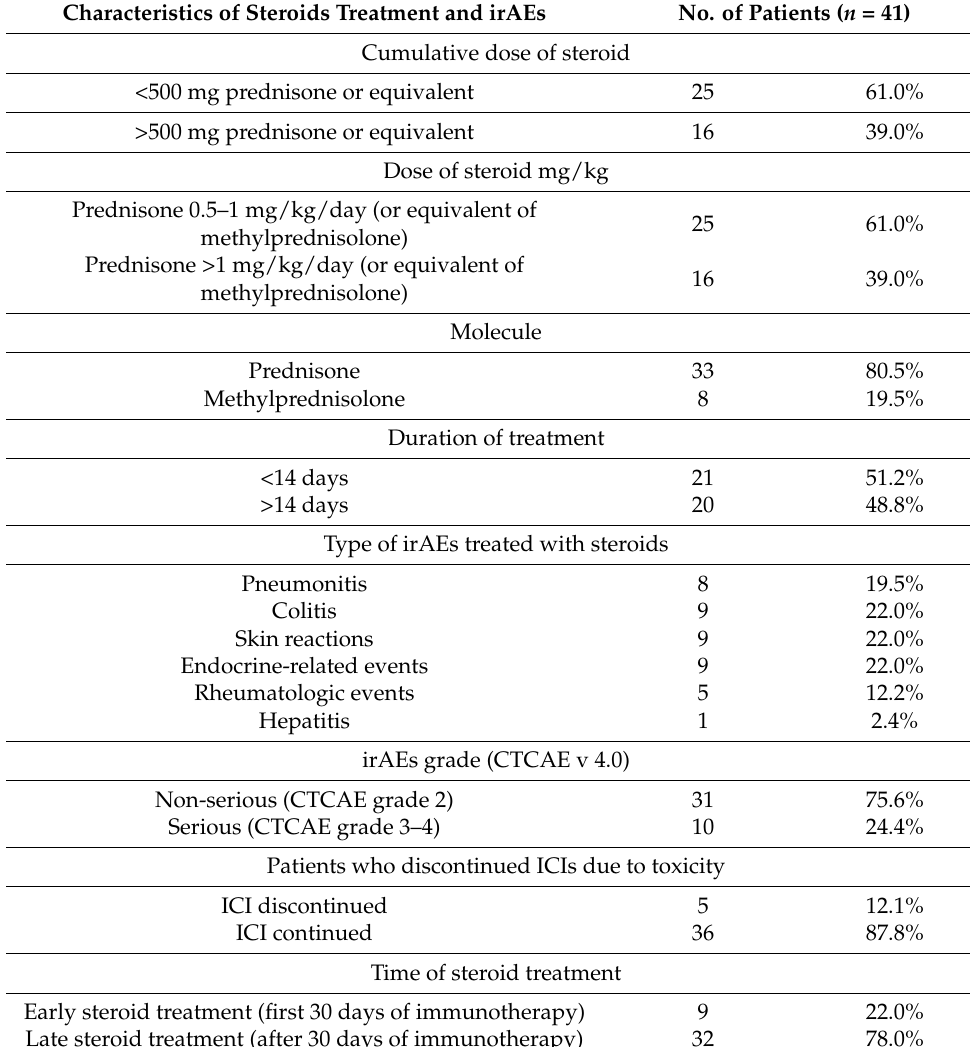
Table 2. Characteristic of steroids treatment and irAEs.